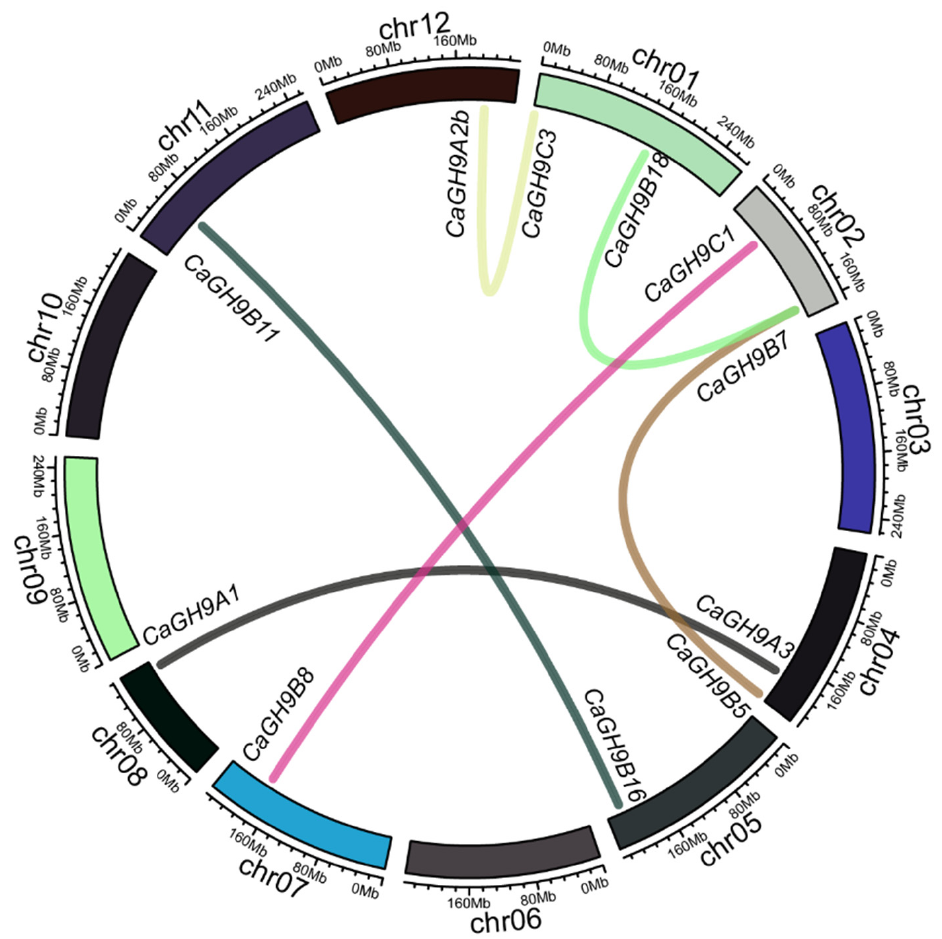
Figure 2. The collinearity among the GH9 family members in pepper. MCSCAN2 was used to calculate the genome-wide collinearity, and the circos plot was performed by Circlize package in R. The reference genome used is CM334 (V1.55).